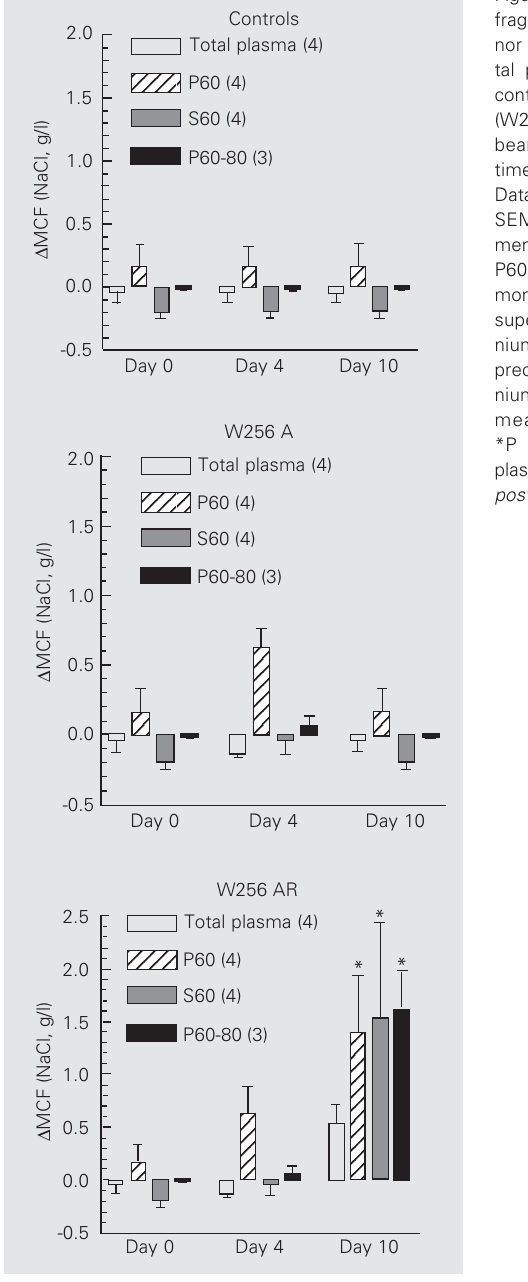
Figure 4. Changes in osmotic fragility induced in normal do- nor RBC by incubation with to- tal plasma and fractions from controls and from Walker 256 (W256) A and W256 AR tumor bearers obtained at different times after tumor inoculation. Data are reported as means ± SEM. The number of experi- ments is given in